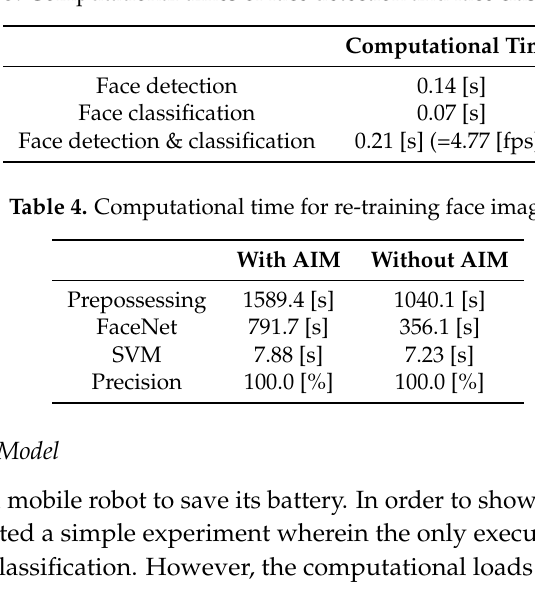
Table 3. Computational times of face detection and face classification.